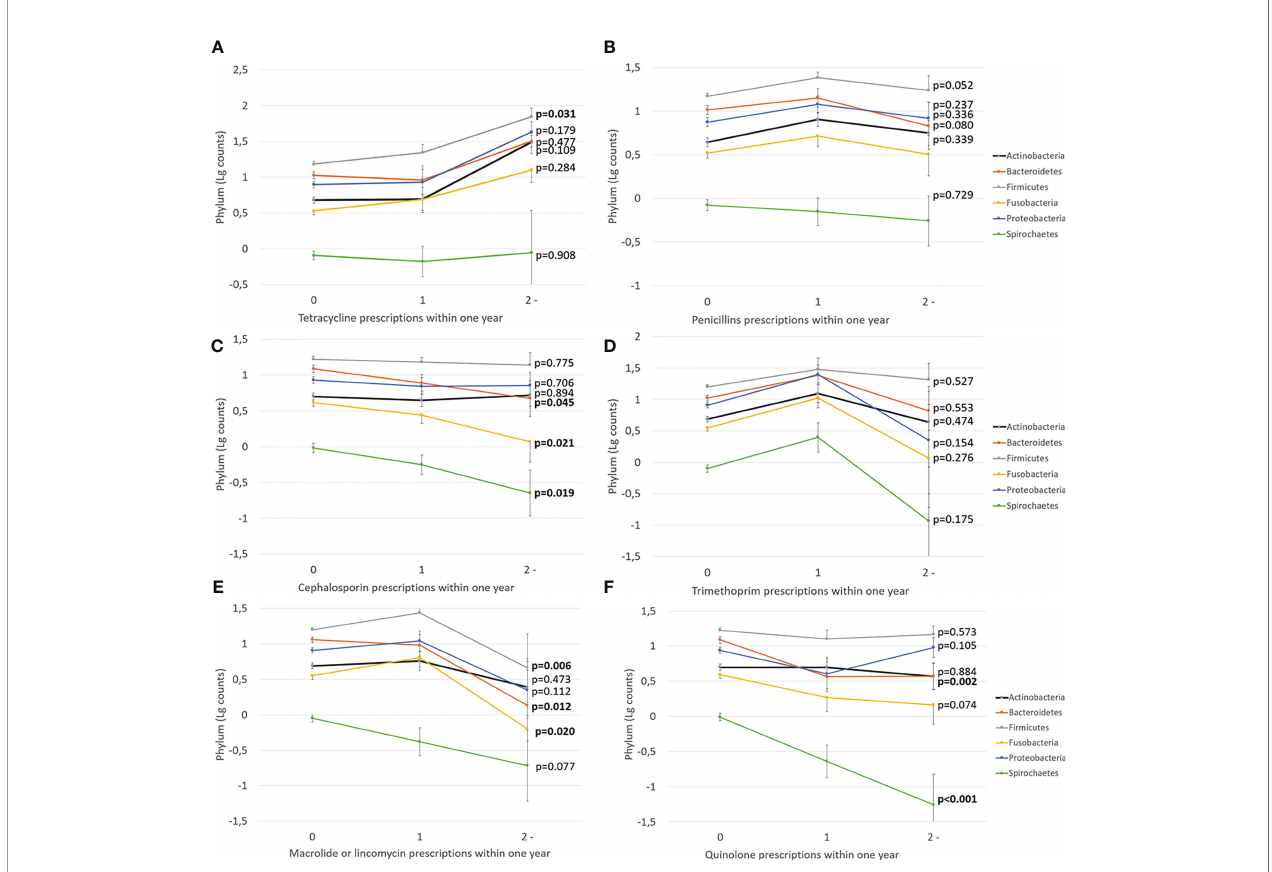
FIGURE 4 | The effect of different antibiotic types on subgingival microbiota. Mean values of log-transformed bacterial counts on the phylum level with the SE are shown. The p-values are for the weighted linear terms from Anova. The antibiotic classes are: (A) tetracycline, (B) penicillins, (C) cephalosporin, (D) trimethoprim, (E) macrolide/lincomycin, and (F) quinolone.